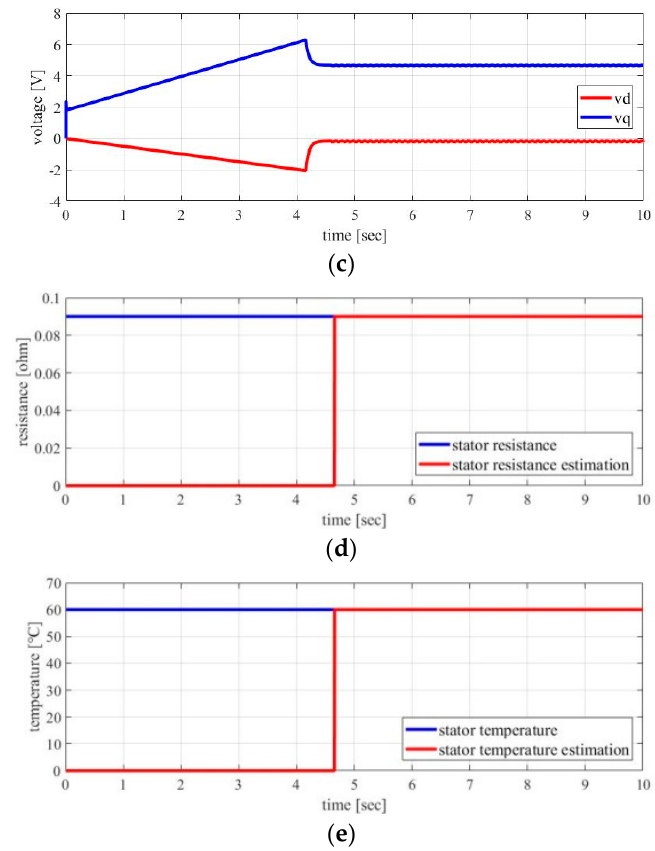
Figure 12. Simulation results: ( a ) motor speed; ( b ) i d and i q ; ( c ) v d and v q ; ( d ) stator resistance estimation; ( e ) stator winding temperature.